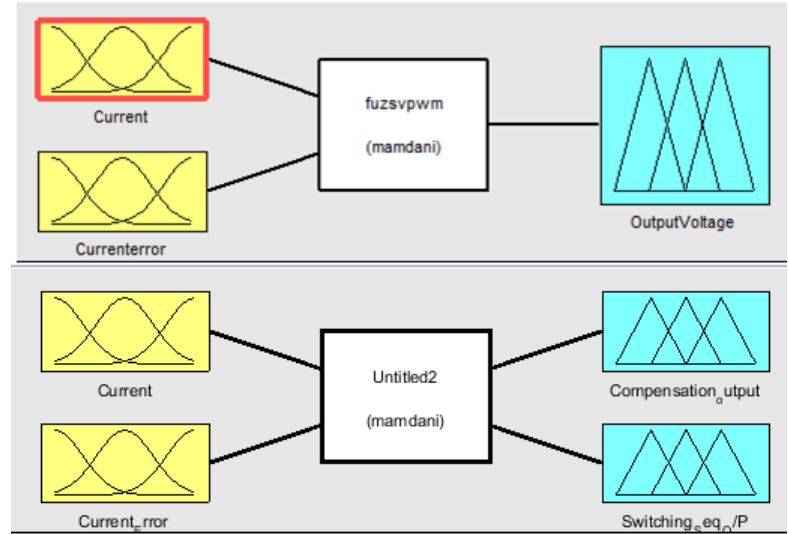
Figure 5. The fuzzy logic controller.